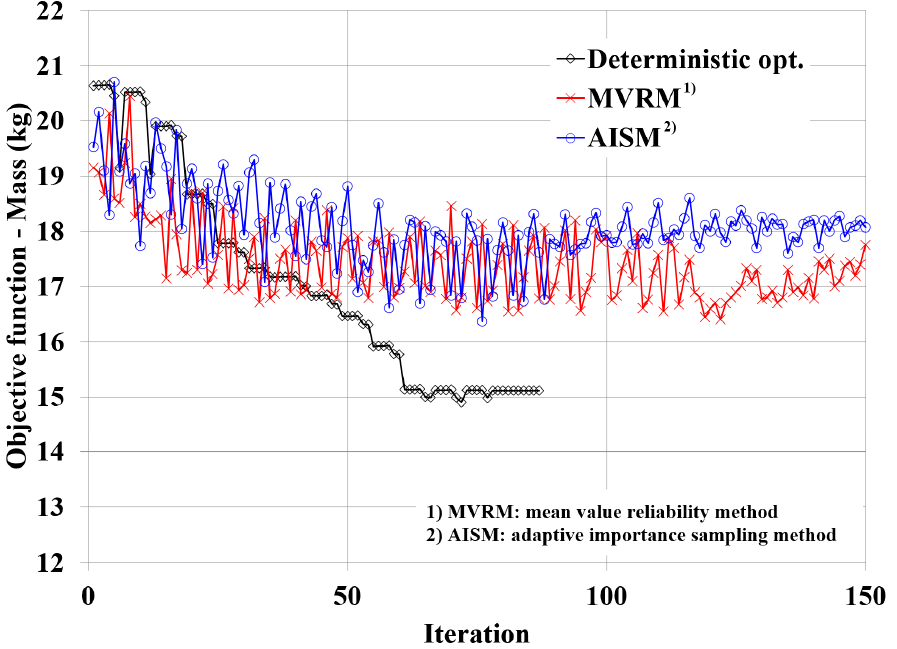
Figure 9. Convergence results of objective function.